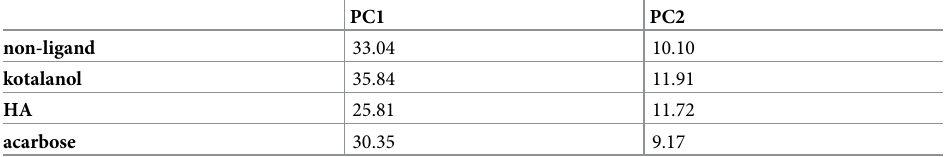
Table 3. The probability(%) for corresponding most stable structures and substable